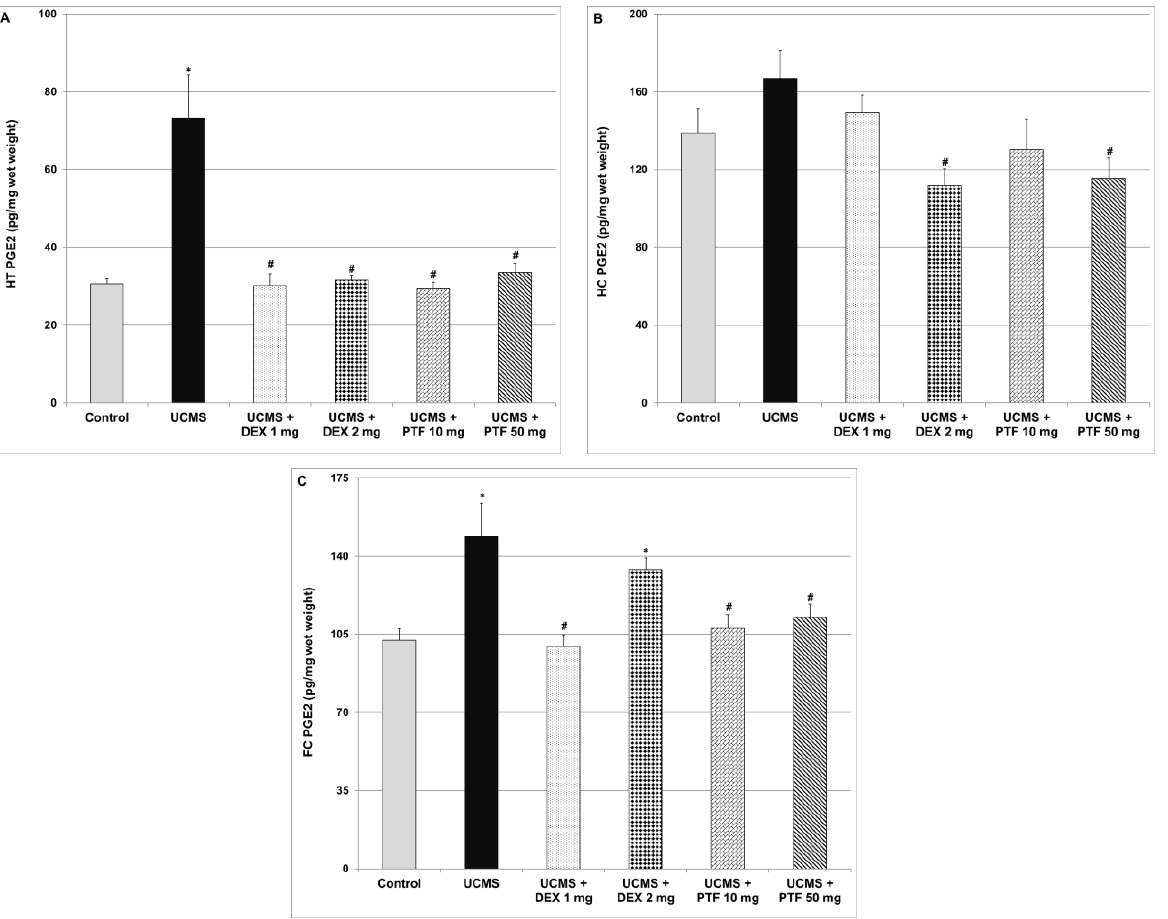
Figure 6. Effects of DEX and PTF on PGE2 levels in brains of UCMS rats. ( A ) Hypothalamus (HT), ( B ) hippocampus (HC) and ( C ) frontal cortex (FC). Values are means ± SEM of 11 – 12 rats in each group. ( A ) One-way ANOVA test: F = 12.85, p = 0.0001; t -test: * p < 0.05 vs. control, # p < 0.05 vs. UCMS. ( B ) One-way ANOVA test: F = 3.73, p = 0.0094; t -test: # p < 0.05 vs. UCMS. ( C ) One-way ANOVA test: F = 5.99, p = 0.0005; t -test: * p < 0.05 vs. control, # p < 0.05 vs.